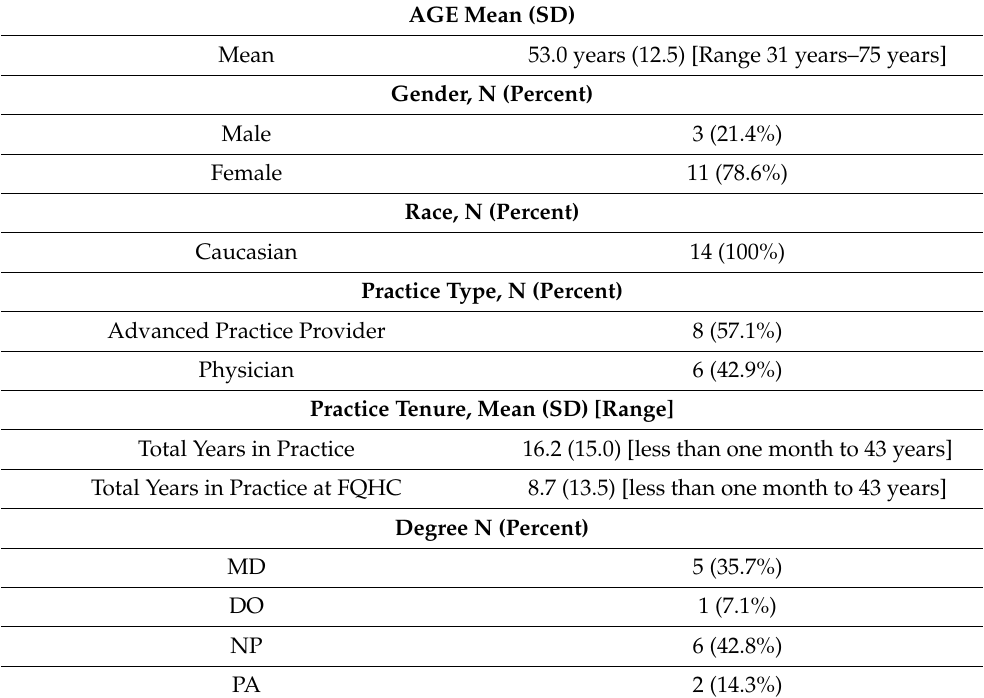
Table 2. Characteristics of Providers Participating in Focus Groups.